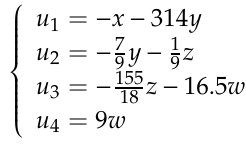
( c ) z t − ( d ) w t − Figure 6. State responses with the controllers (40), (43), and (44). ( a ) x t − ; ( b ) y t − ; ( c ) z t − ; ( d ) w t − .